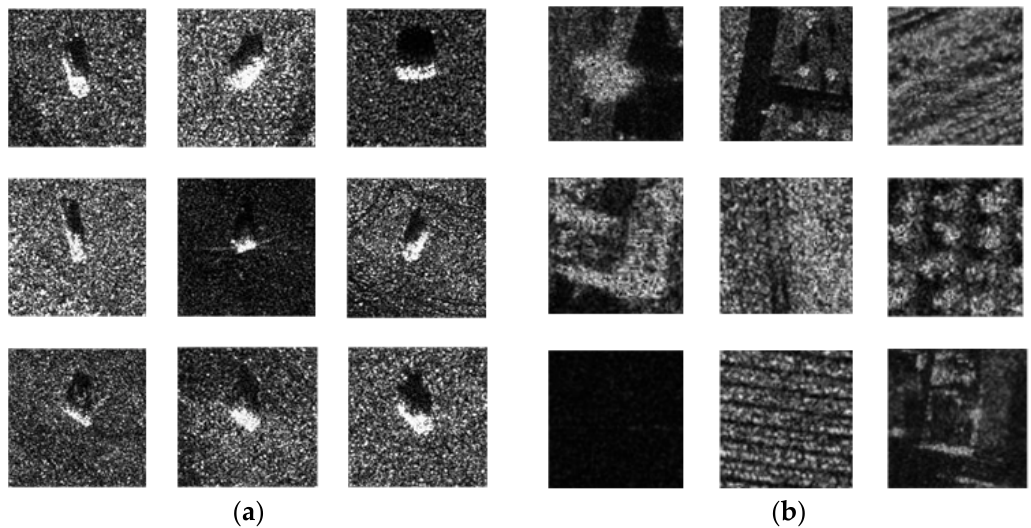
Figure 8. Training samples. ( a ) Target sample. ( b ) Background sample.